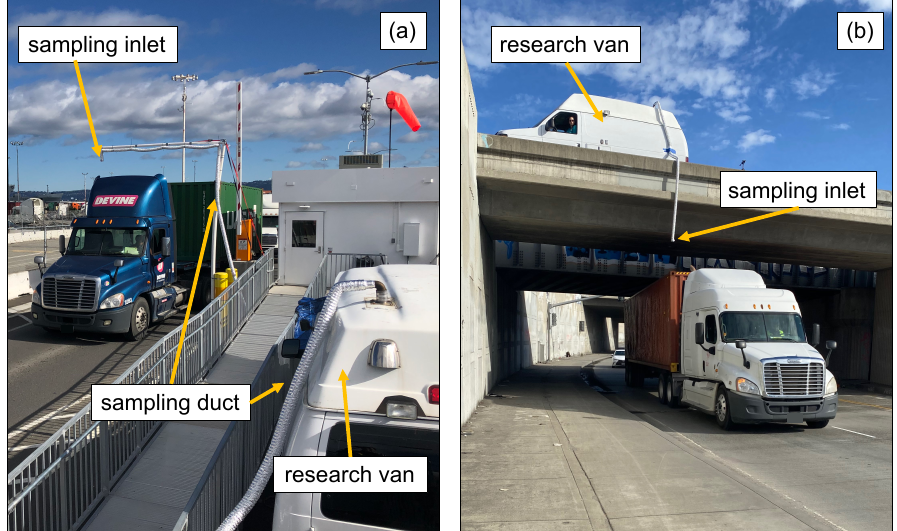
Figure A4. Field sampling of Port of Oakland drayage trucks at the ( a ) Terminal Entrance and on the ( b ) Arterial Road. The sampling inlet was aligned with truck’s right vertical exhaust stack and the sampling duct delivered sampled truck exhaust to the suite of sensors housed in the research